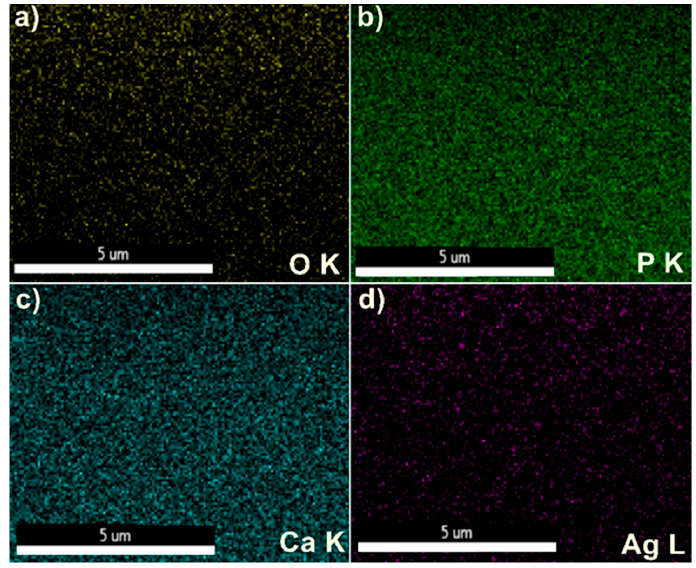
Figure 9. Elemental mapping of the Ag:HAp-S2 composite layers.